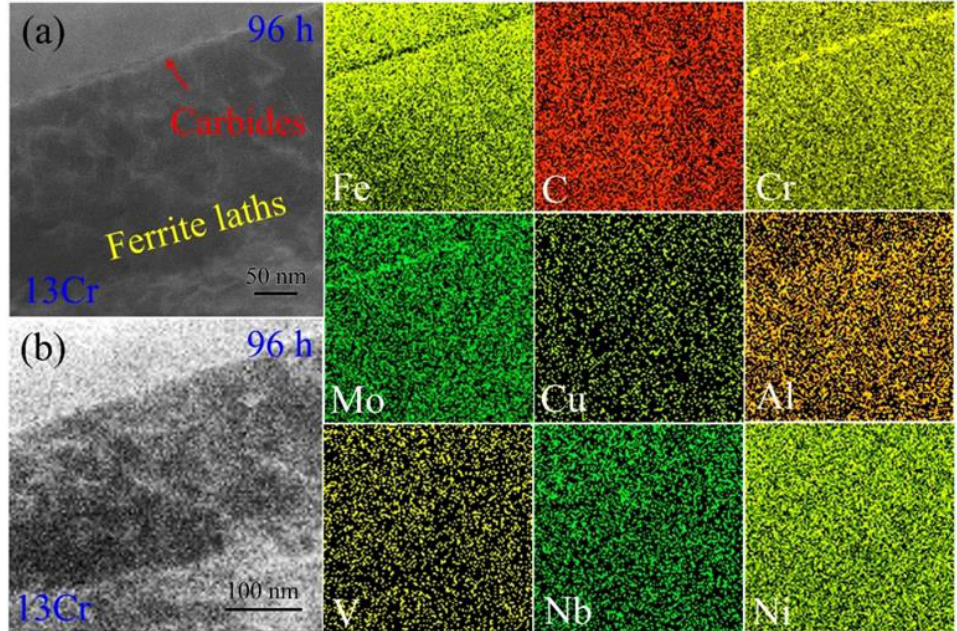
Figure 10. Elemental distribution around ferrite lath boundaries in the 13Cr samples crept for 96 h: ( a ) HAADF STEM image and ( b ) HAADF EDS maps of alloying elements, such as Fe, C, Cr, Mo, Cu, Al, V, Nb and Ni.